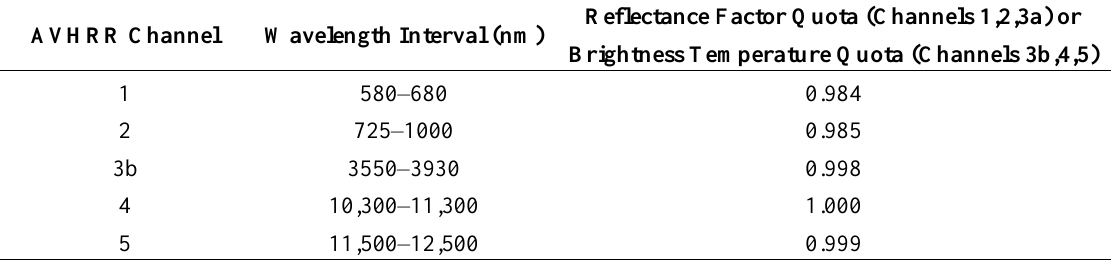
Table 8. Reflectance factor quotas or brightness temperature quotas with respect to MODIS (AVHRR/MODIS) deduced from NOAA-18 vs. AQUA SNO inter-comparisons in the period of 2007–2009.